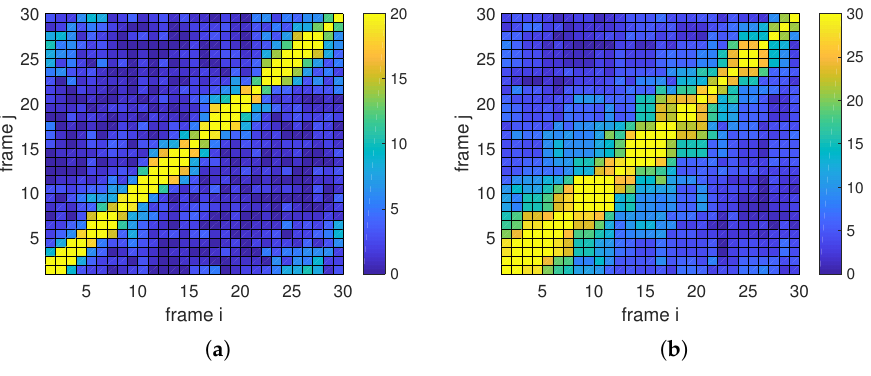
Figure 9. Matching relations of discontinuous frames: ( a ) matching relation of Dog frames; ( b ) matching relation of Panda